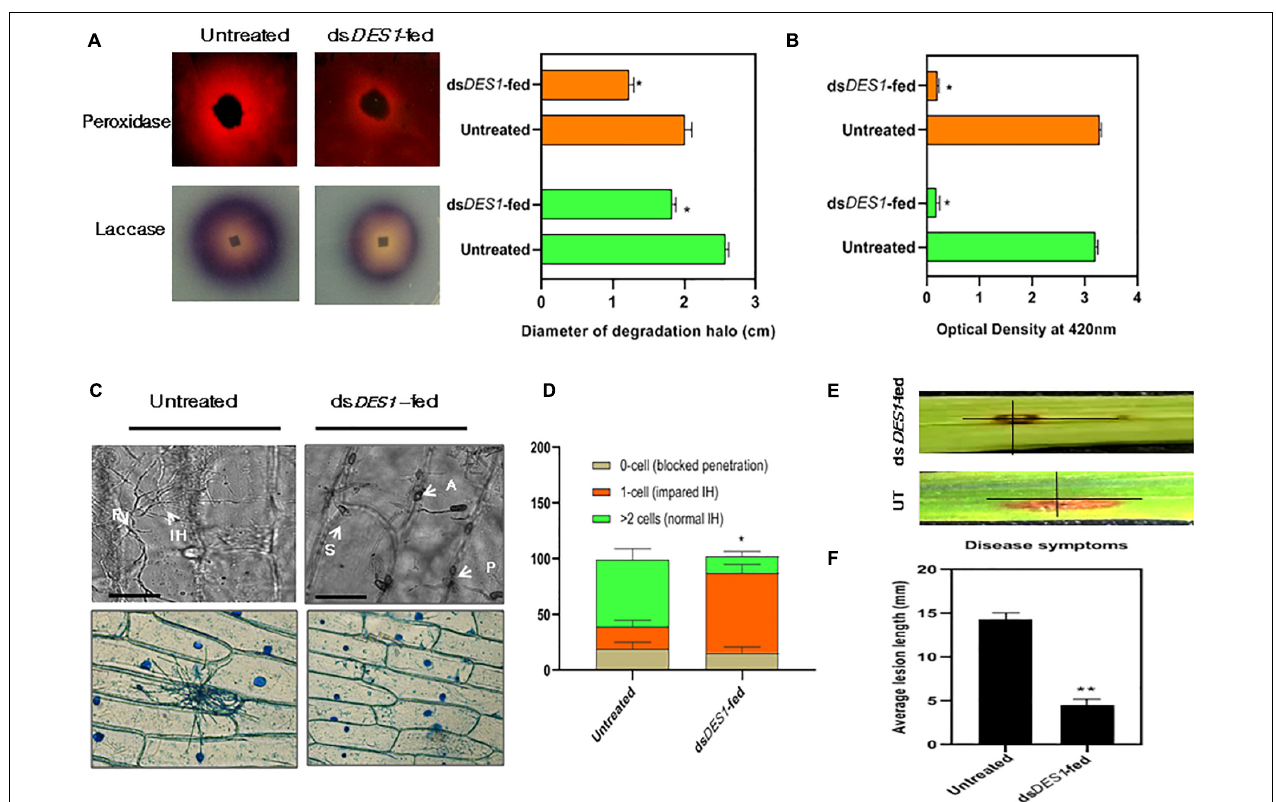
FIGURE 5 | Extracellular enzyme activity and virulence potential of ds DES1 -fed strain. (A) The extracellular laccase and peroxidase activity of the in vitro -ds DES1 -fed strain on CM plates supplemented with ABTS and Congo red (CR), respectively. The average diameter of halo or discoloration indicator of substrate breakdown was measured in triplicates from 5-day-old plates. (B) Activities of laccases (green) and peroxidases (orange) in culture filtrates of the untreated and ds DES1 -fed strain. (C) The upper panel indicates the 40 × -magnified differential interference contrast (DIC) image of onion peel infected with untreated and ds DES1 -fed strain. The white arrows indicate the spore, S; appressoria, A; point of penetration, P; invasive hyphal, (IH) growth. The lower panel shows a 10 × -magnified bright field image of Lactophenol blue-stained fungal infection units grown on onion epidermal cells. This is indicative of the cell-to-cell movement of IH and host colonization. (D) Graphical representation of the fraction of infection units that showed differential ease of host-colonization, beyond the primary site of penetration. The potential for cell-to-cell movement of IH was color-coded based on the number of cells they penetrated (0– > 2). At least 50 different infection units were observed for each set, and the experiment was repeated thrice. (E,F) Spot inoculation of detached rice leaves with spores isolated from the in vitro ds DES1 -fed strain and untreated wild-type strain. Average length of lesion was measured for each set with approximately 50 leaves ( ≈ 100 lesions). The error bars represent ± SD, and * and ** denote statistical significance at the P ≤ 0.05 and P ≤ 0.01